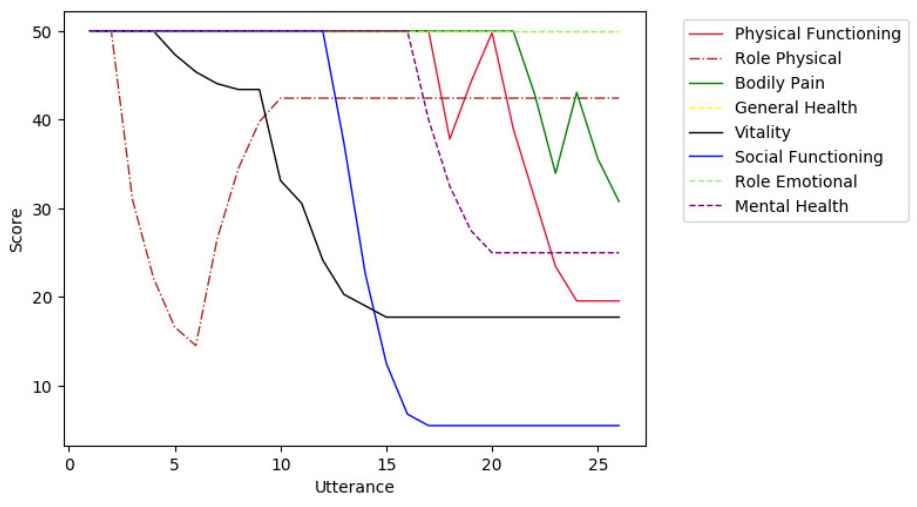
Figure 6. Trend of the QOL